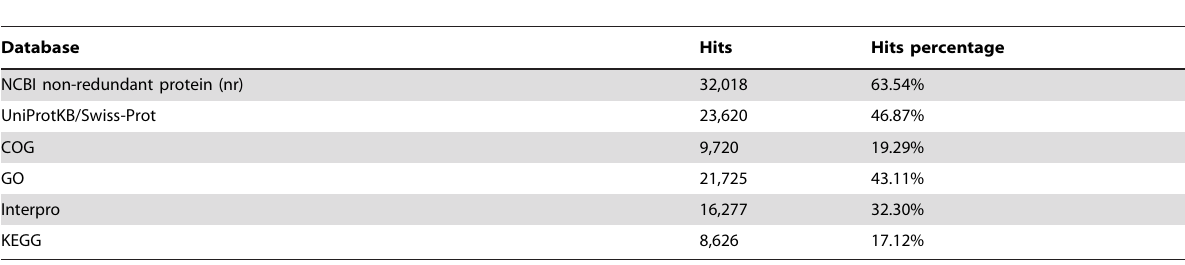
Table 3. Summary of the annotations of the 50,384 contigs.